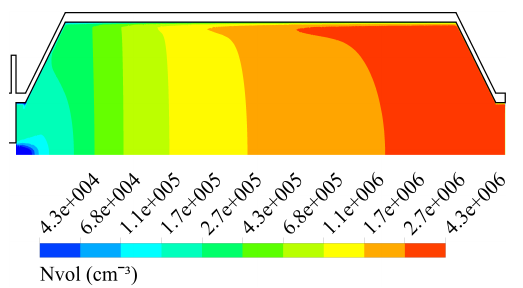
Figure 8. The volatile nucleation mode concentration in the aging chamber region when there is [ H 2 SO 4 ] = 1 . 47 × 10 11 cm − 3 in raw exhaust of R case with n sa = 0 . 25. The figure is scaled vertically with a factor of 10.